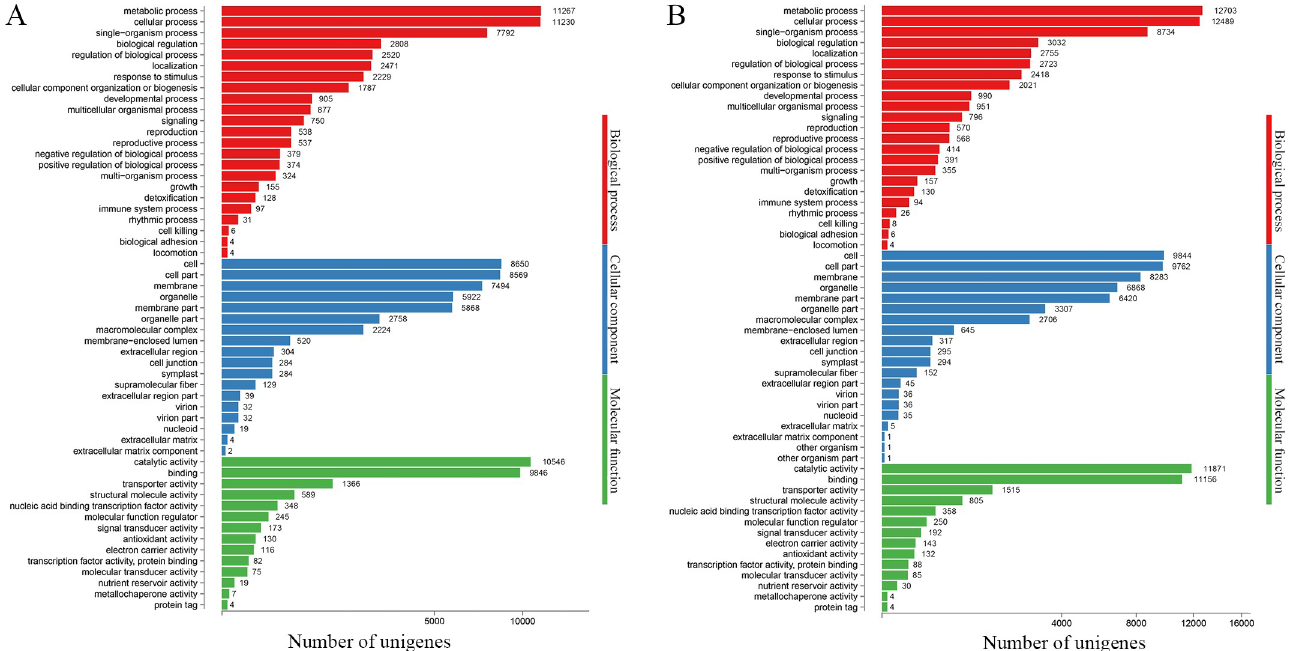
Fig 3. Gene ontology (GO) classification of assembled unigenes of two Parrotia subaequalis transcriptomes. (A) Parrotia subaequalis (TX); (B) Parrotia subaequalis